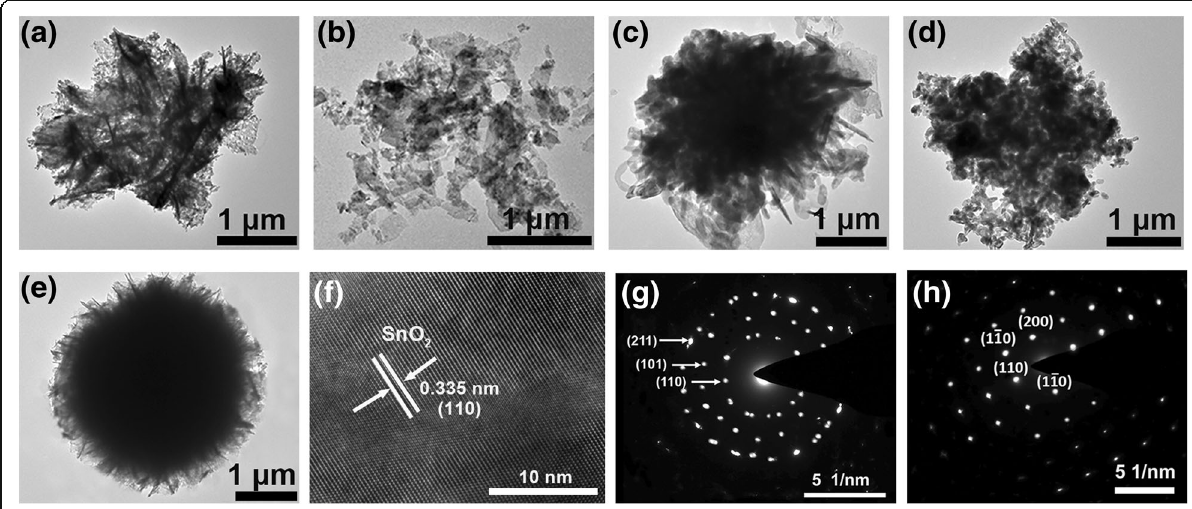
Fig. 5 Low-magnification TEM images of SnO 2 samples. a S 0 , b S TritonX-100 , c S HMT , d S PEI , and e S PVP . f HRTEM micrograph showing enlarged lattice images of S HMT . g SAED patterns of S 0 . h SAED patterns of S